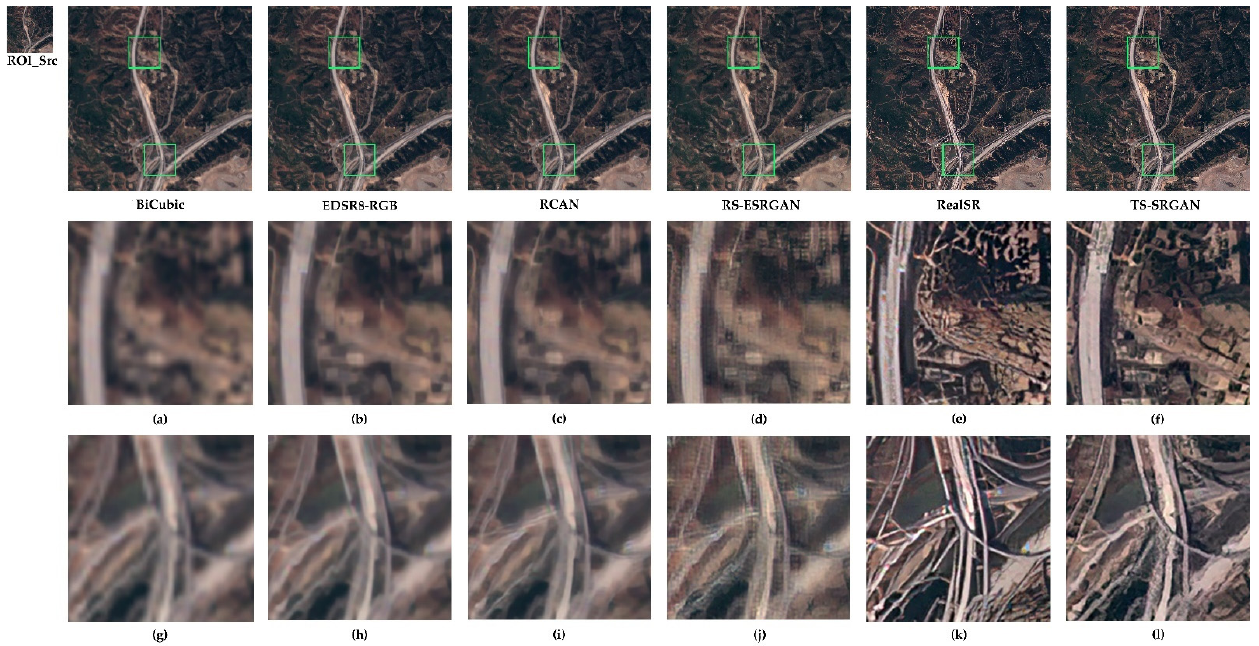
Figure 20. Comparison of visual effects of the generated images of the region containing farmlands and sandy terrain. NR-IQA of images (NIQE, BRISQUE, PIQE): BiCubic (0.49, 55.53, 94.76), EDSR8- RGB (5.83, 49.99, 85.93), RCAN (4.37, 45.64, 46.14), RS-ESRGAN (3.35, 21.84, 8.59), RealSR (2.96, 26.74, 13.01), TS-SRGAN (2.46, 8.07, 8.84). The subfigures ( a – l ) in the figure represent an enlarged view of the local details in the green boxes in the generated image.